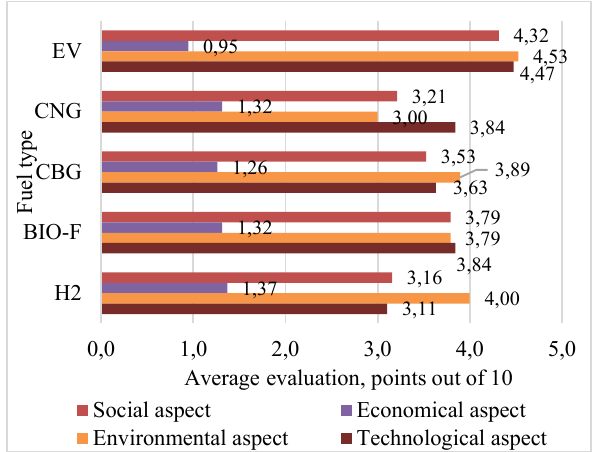
Figure 2. Evaluation of each fuel type according to given criteria.